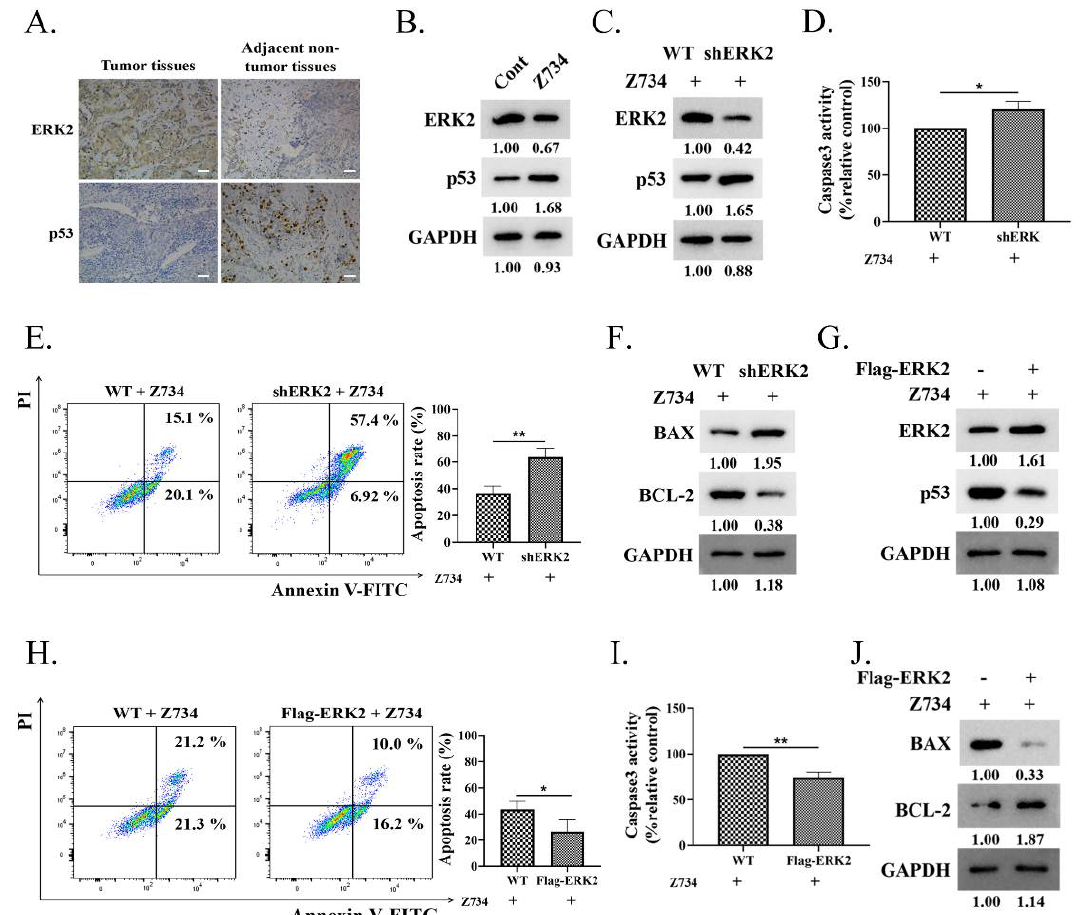
Figure 3. ERK2 inhibition promotes Z734–mediated apoptosis in MCF–7 cells. ( A ) ERK2 and p53 exhibit various levels of expression in tissues and in adjacent non–tumor tissues. Scale bars = 50